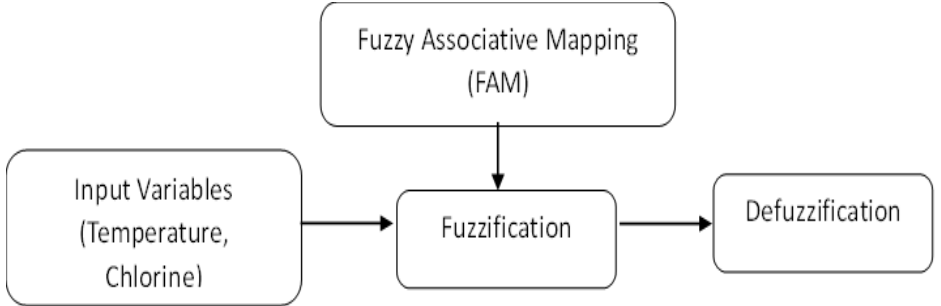
Figure 3. Prediction of chlorine level using fuzzy rules.